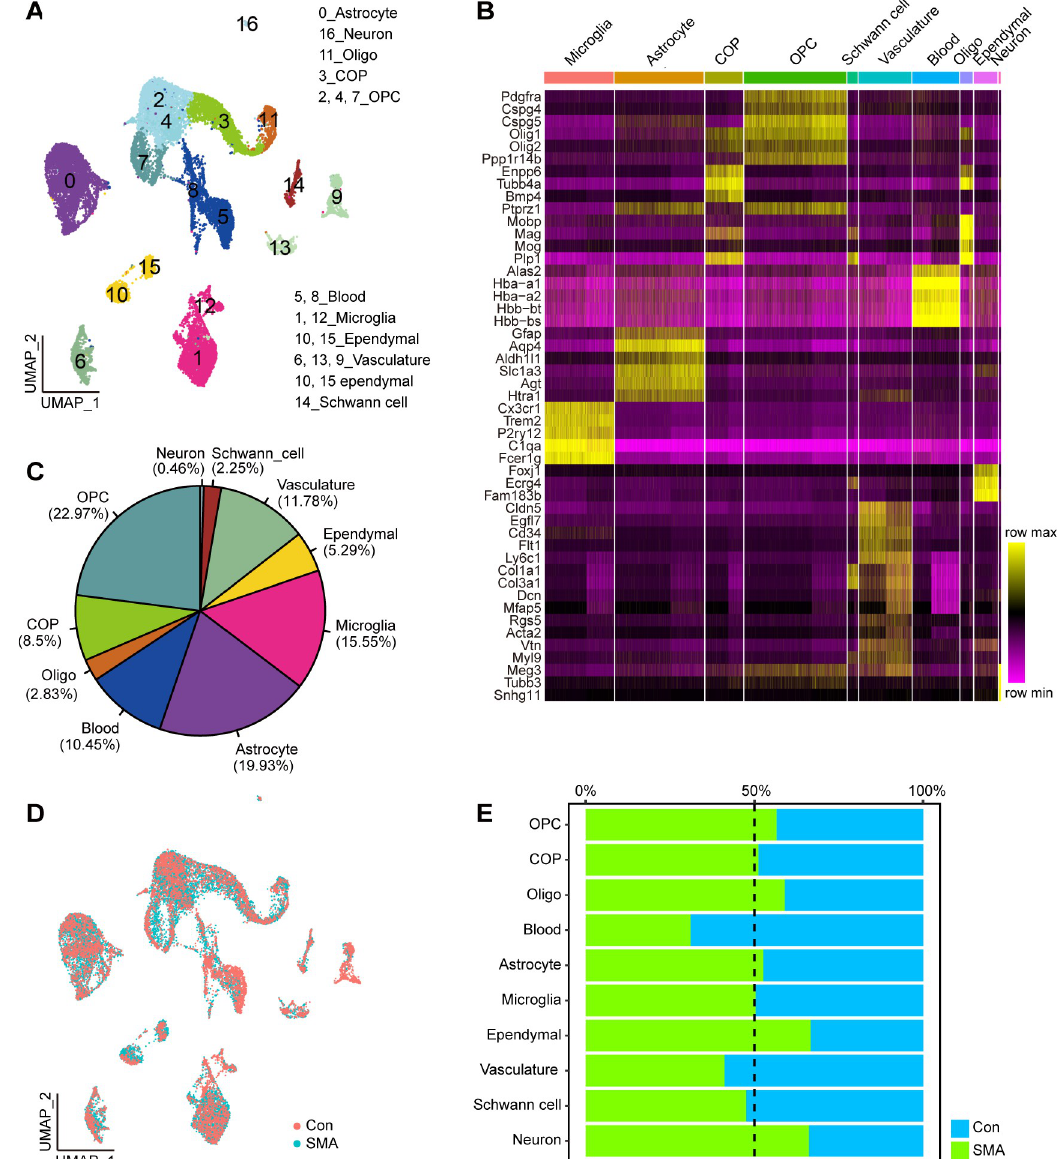
Fig 1. Cell type identification. (A) UMAP visualization showing the cluster of cell type from scRNA-seq. (B) The heatmap shows the average expression of marker genes for each cell type. The darker the yellow, the higher the expression level. (C) The proportion of each cell type to the total number of cells. (D) UMAP visualization showing the distribution of SMA and control cells. (E) Proportion of cells from SMA or control samples in each cell